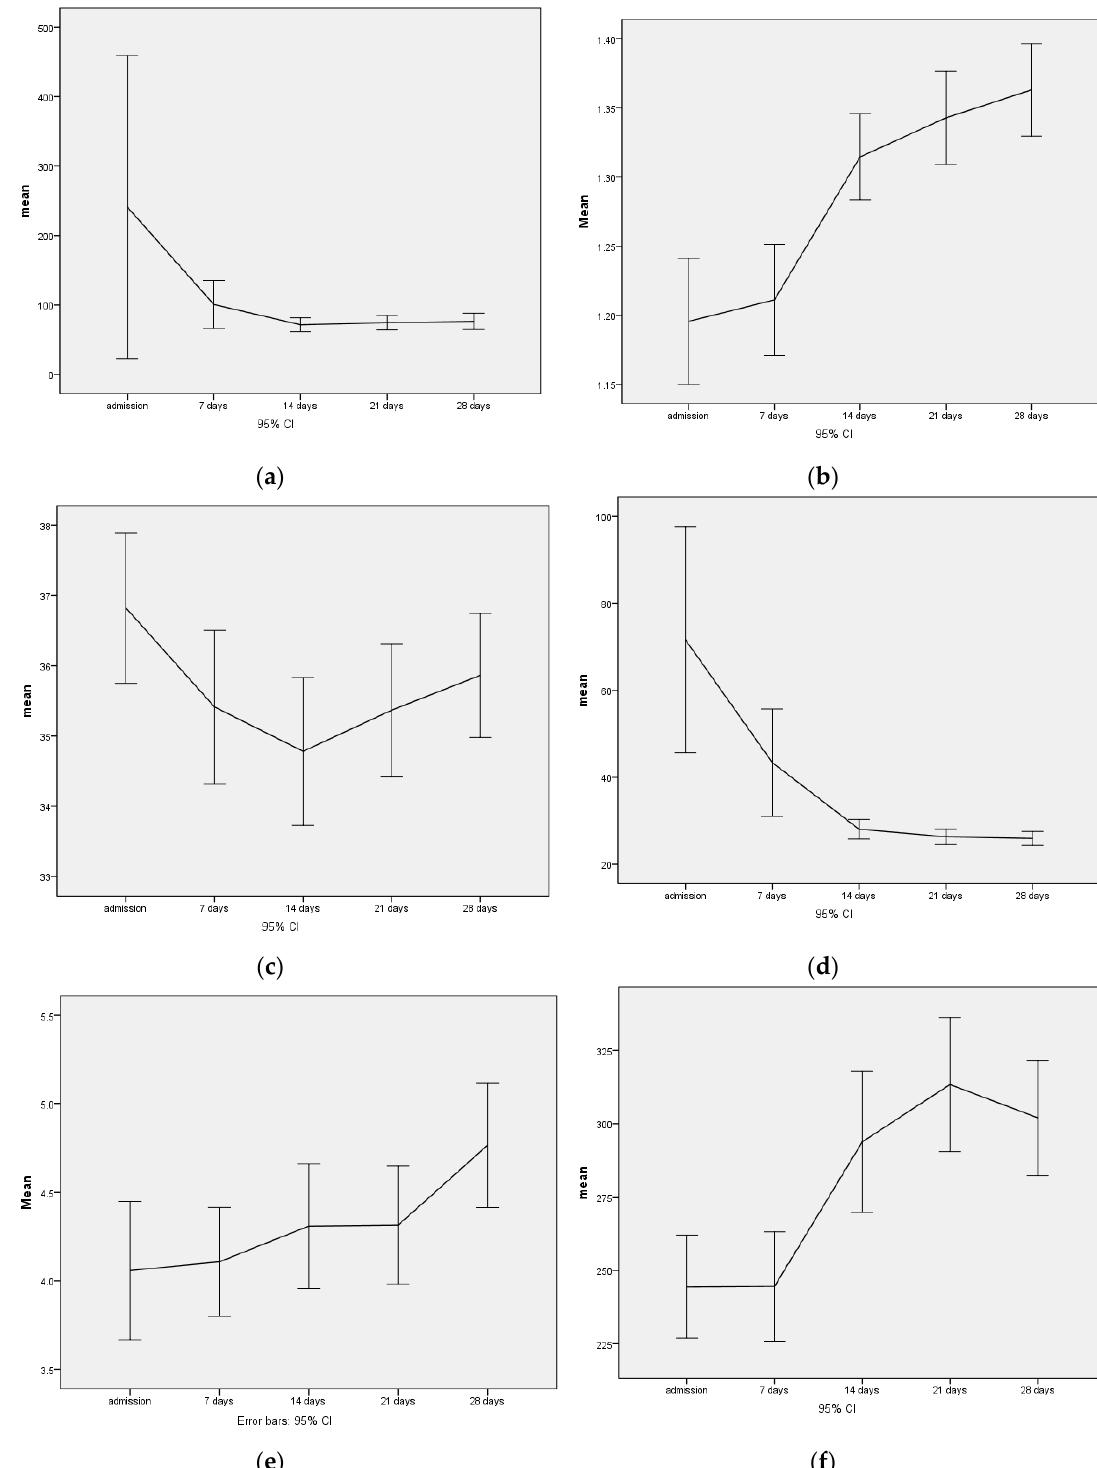
Figure 1. The course of creatine kinase (CK), inorganic phosphate (Phos) × 100, hematocrit (HK), and aspartate aminotransferase (GOT) leukocytes and platelets over four weeks with F-values of the measurement repeatability analysis. T1 to T5 (T1 intake, followed by weekly intervals of the laboratory survey). ( a ) Creatin kinase (F 2,3 df 4, p 0.056.); ( b ) Phosphate (F 23,9, df 4, p 0.000); ( c ) Hematocrit (F 12,3 df 4, p 0.000); ( d ) GOT (F 13,8 df 4, p 0.000); ( e ) Leucocytes (F 8,9, df 4, p 0.000); ( f ) Platelets (F 19,8, df 4 p 0.000.). T1, admission; T5, 28 days after admission.